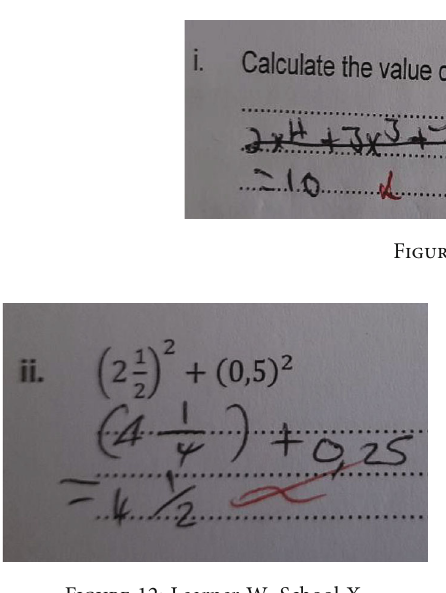
Figure 12: Learner W, School X.